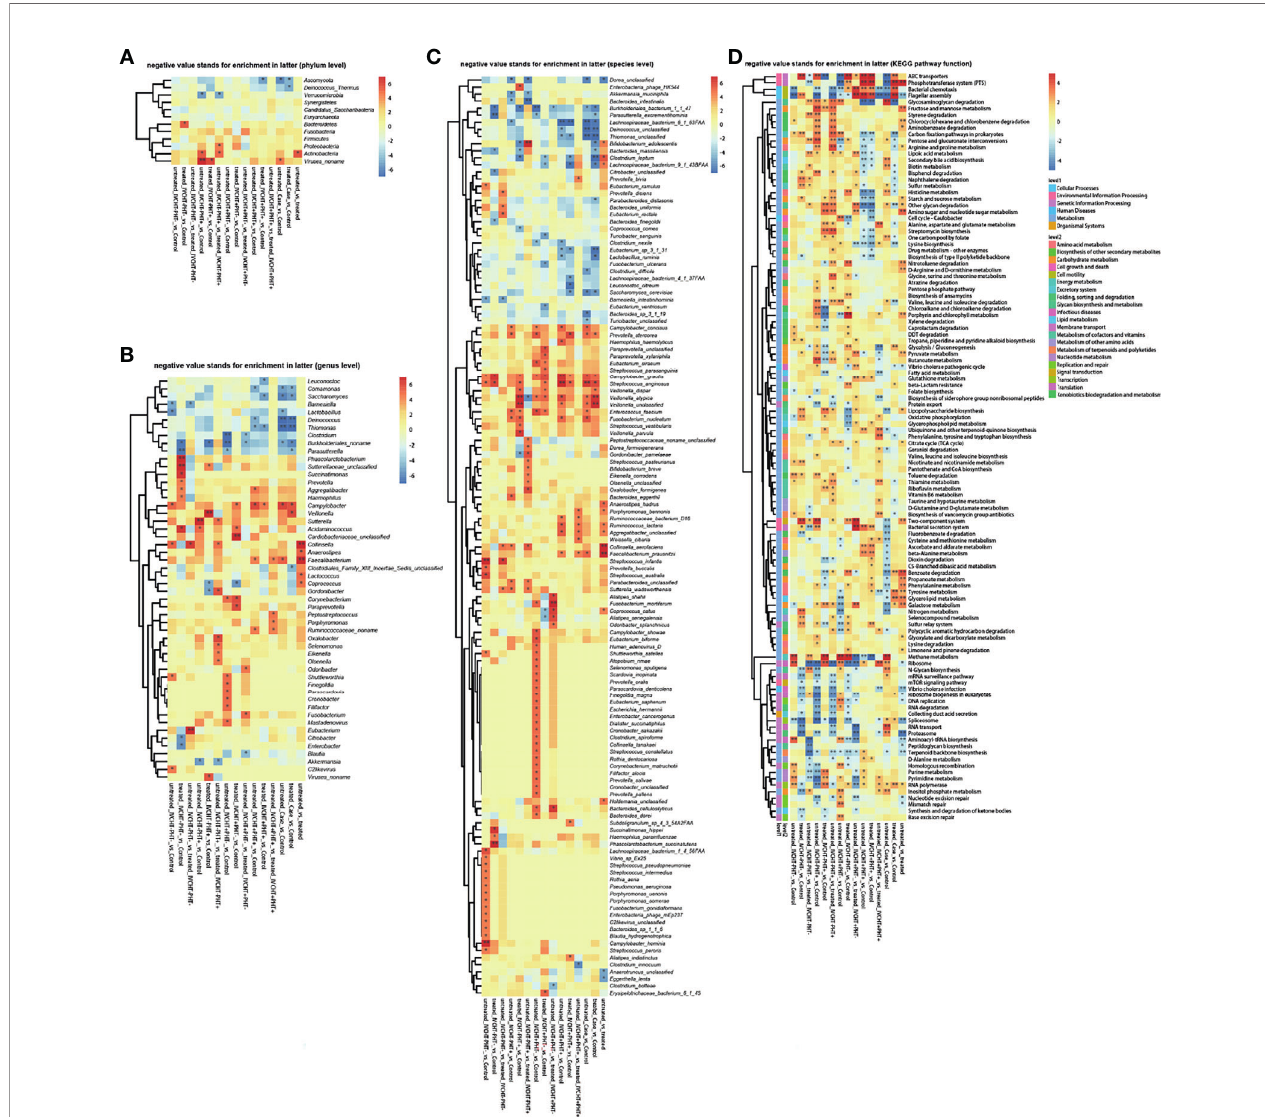
FIGURE 1 | Faecal metagenomics pro fi le in patients with B-CS: (A) Heat map of different phyla. (B) Heat map of different genera. (C) Heat map of different species. (D) KEGG pathway analysis of B-CS. Pathways involved in energy metabolism and substance transport, among others, were altered. *P < 0.05, **P < 0.01, enrichment direction as shown. B-CS, Budd-Chiari syndrome; KEGG, Kyoto Encyclopaedia of Genes and